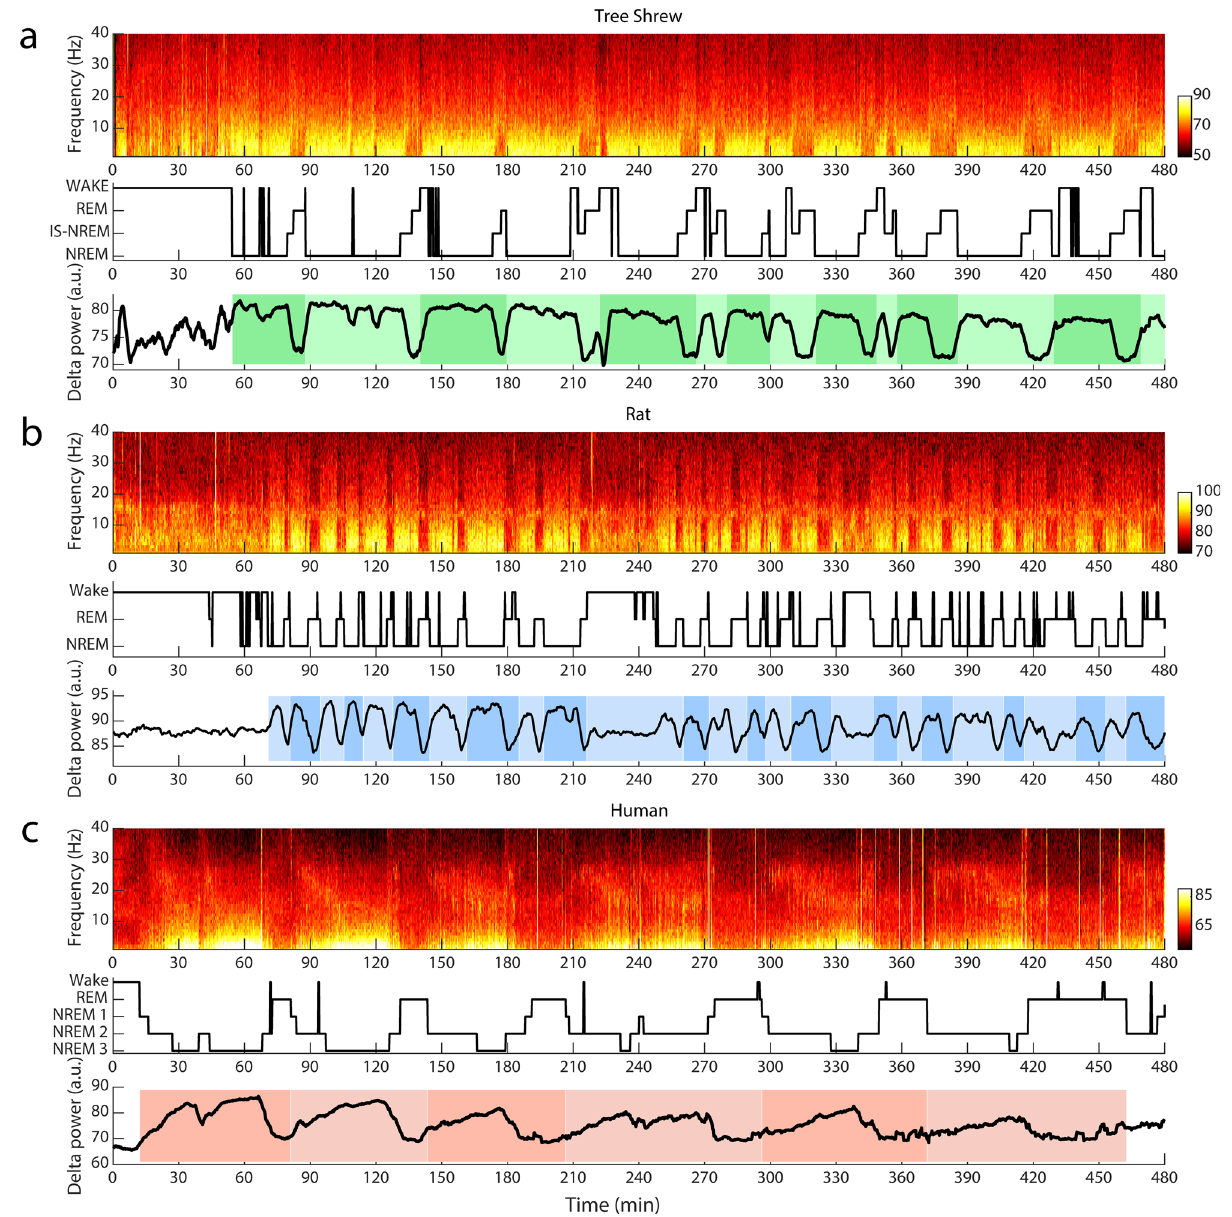
Fig. 3 Example sleep recording of tree shrews, rats, and humans. a Top, spectrogram of an 8 h recording period for an example tree shrew. Middle, hypnogram showing NREM sleep, IS-NREM as well as REM and Wake. Bottom panel, the corresponding delta power (0.5 – 4 Hz) trace with colored patches indicating sleep cycles, and changes in shading indicating independent sleep cycles. ( b ) and ( c ) are as ( a ) but for example rat and human respectively. Note, correspondence of sleep cycles and delta power fl uctuations across species. Color bars re fl ect Fourier power in arbitrary